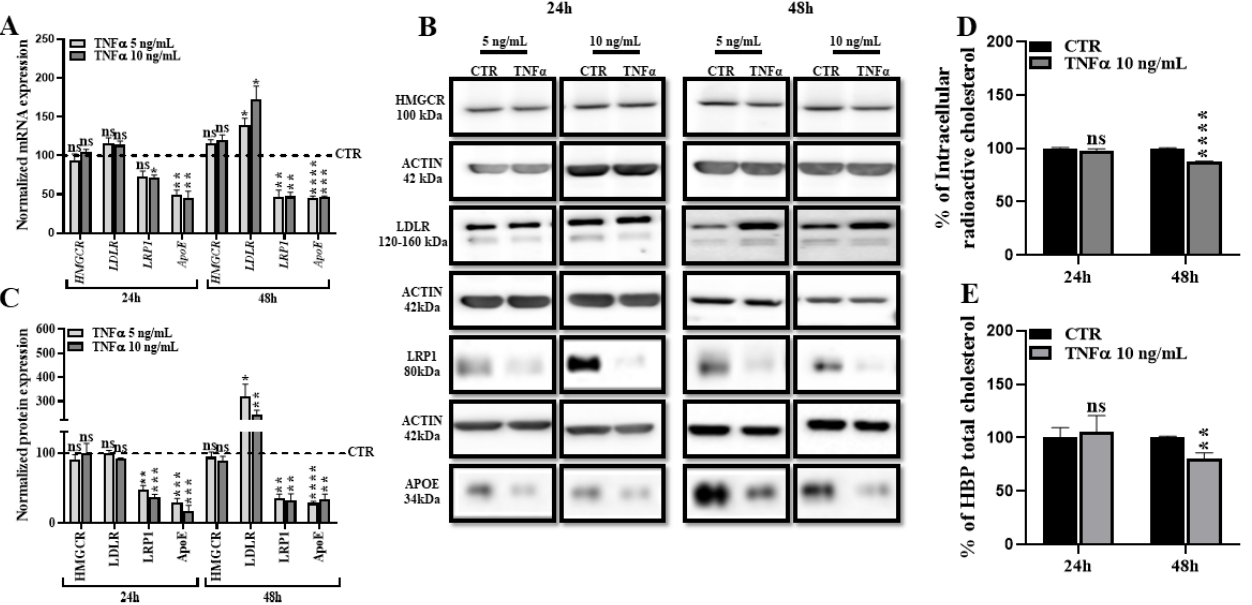
Figure 2. TNF α decreases HBP intracellular cholesterol level without modulating HMGCR expression. ( A ). Transcriptional expression of HMGCR , LDLR , LRP1 and APOE was measured by RT-qPCR. Each bar represents the level of mRNA expression normalized to the housekeeping gene GAPDH , relative to the control condition (CTR). Data are shown as the mean ± SEM of three experiments from pooled triplicates (N = 3). Statistical analysis: Student’s t -test, ns: non-significant, * p < 0.05, ** p < 0.01, *** p < 0.001, **** p < 0.0001. ( B ). HMGCR , LDLR, LRP1 and APOE protein level was assessed by Western blot. Among all the investigated proteins, only APOE was quantified from the supernatant and normalized to albumin. ( C ). Each bar represents the level of quantified protein normalized to ACTIN, relative to the CTR. Data are shown as the mean ± SEM of three independent experiments (N = 3). Statistical analysis: Student’s t -test, ns: non-significant, * p < 0.05, ** p < 0.01, *** p < 0.001, **** p < 0.0001. ( D ). Total intracellular cholesterol accumulations were first monitored by using radiolabeled cholesterol as mentioned in the material and methods section. Data are shown